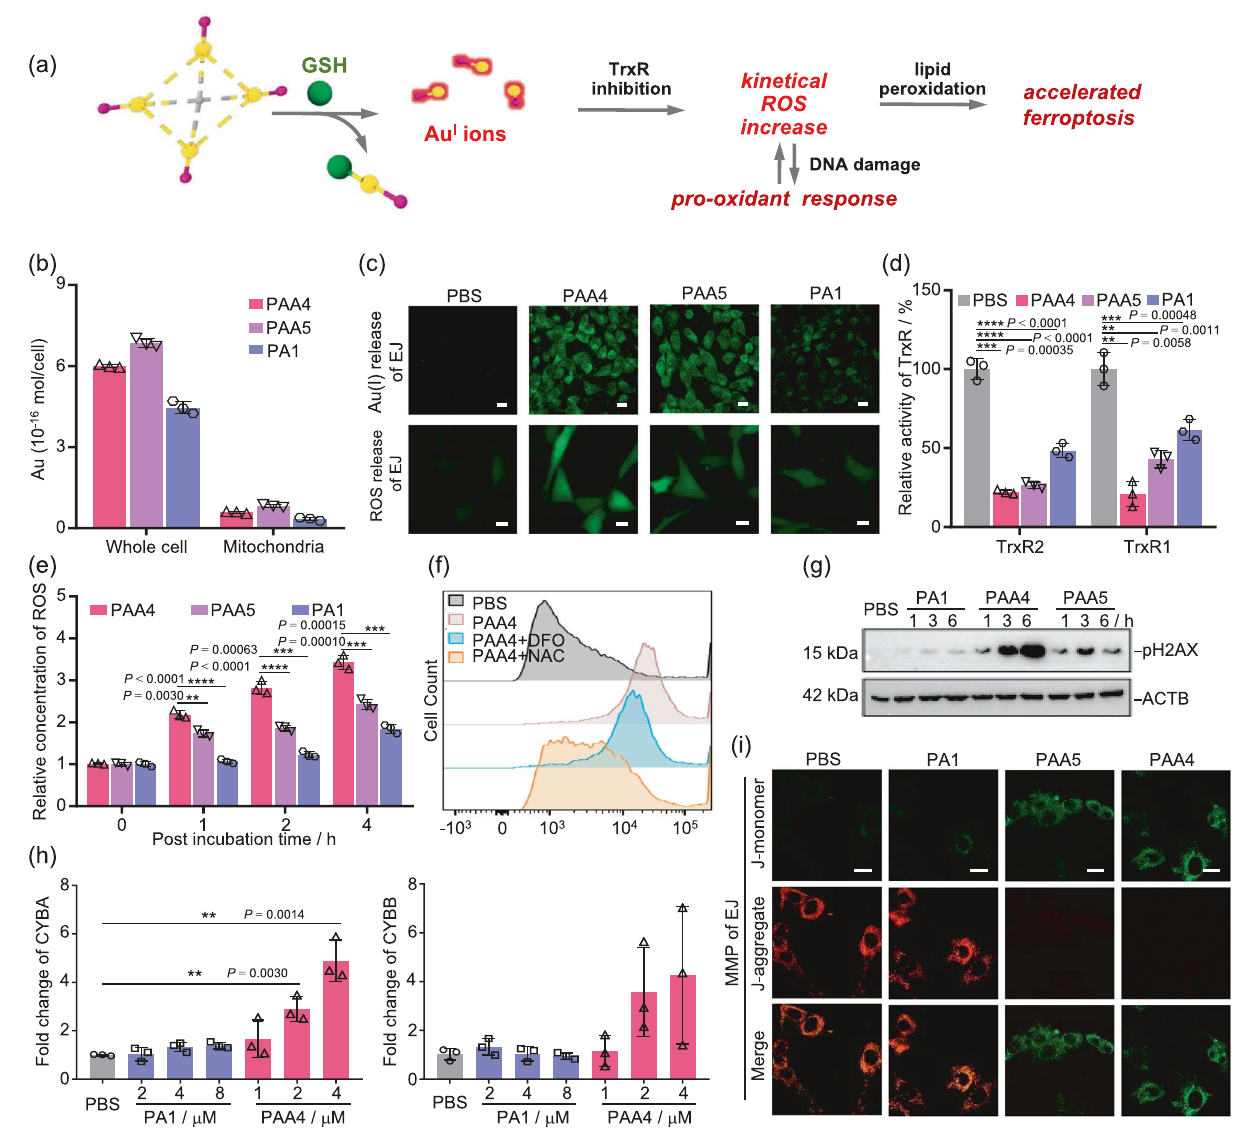
Fig. 5 | Mechanistic studies on ferroptosis induced by PAA4 and PAA5. a Schematic pharmacological pathways of hypercarbon-centered gold(I) cluster. b Content of PAA4 , PAA5 and PA1 in the whole EJ cells and cell-extracted mito- chondria determined by ICP-MS ( c Au(I) clusters =1.5 μ M, c PA1 =6.0 μ M, 4h incuba- tion). c Release of Au(I) ions monitored by confocal microscopy in the 2,3,6,7- tetrahydro-1H,5H-pyrido[3,2,1-ij]quinolin-8-yl-3-phenylpropiolate stained EJ cells, and ROS release monitored by confocal microscopy in the 2 ′ ,7 ′ -dichloro fl uorescin diacetate(DCFH-DA,10.0 μ M)stainedEJcellstreatedwith PAA4 , PAA5 (1.5 μ M,4h incubation) and PA1 (6.0 μ M, 4h incubation) relative to the PBS blank trial. Scale bar: 20mm. Excitation:488nm. d TrxRactivity inhibition upon the treatment with PAA4 , PAA5 (1.5 μ M, 4h incubation) and PA1 (6.0 μ M, 4h incubation) relative to thePBSblanktrial. e Time-dependentintracellularROSchangeinEJcellstreatedby PAA4 , PAA5 (1.5 μ M, 4h incubation), and PA1 (6.0 μ M, 4h incubation). The ROS concentration of EJ cells before treatment is referred as the control value. f